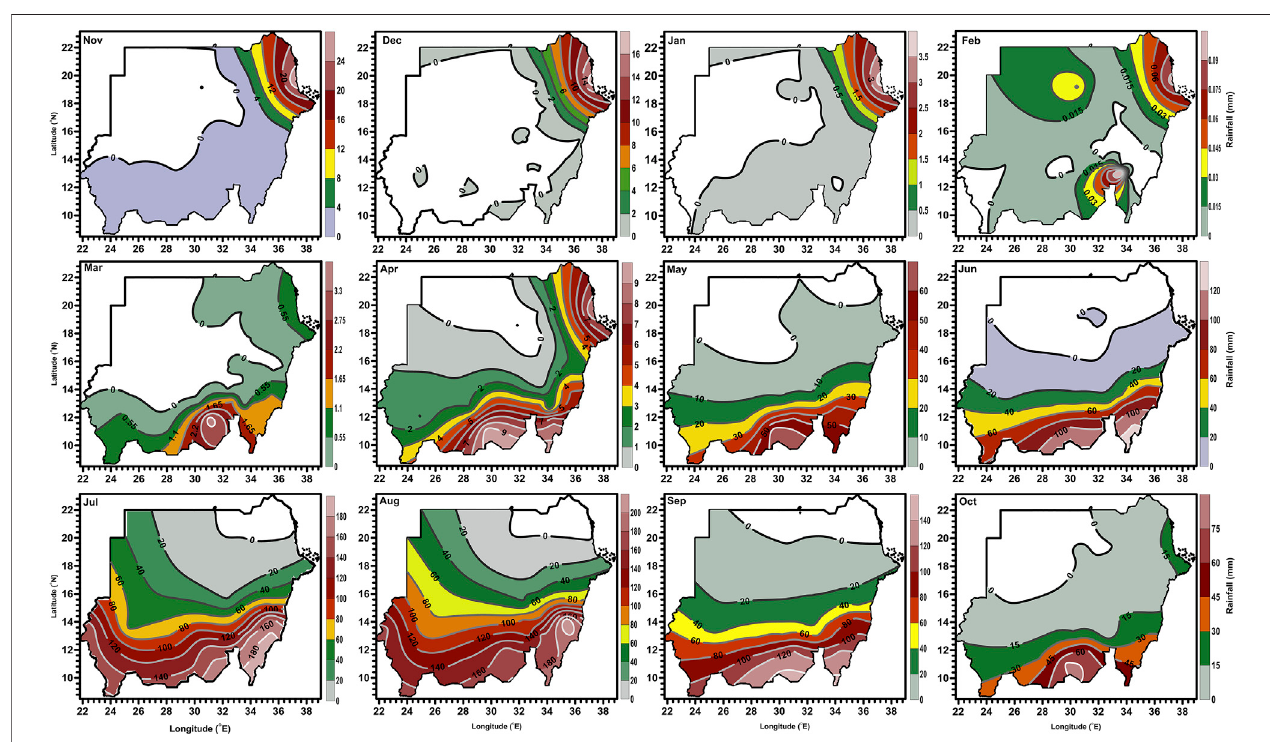
FIGURE 3 | The spatial distribution of monthly mean rainfall in Sudan between 1981 and 2010.